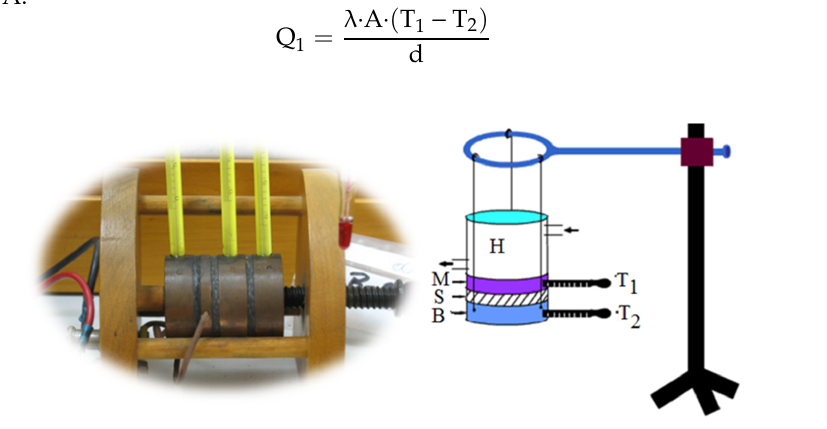
Figure 5. Lee’s apparatus.